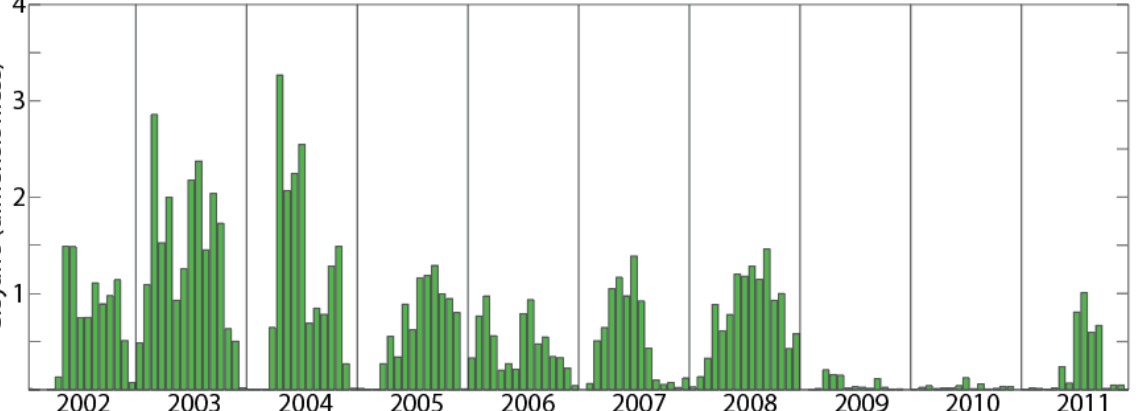
Figure 6. Aggregated CI cyano biomass for each 10-day composite over the 10 years of the study for Green Bay showing a high degree of interannual variability.